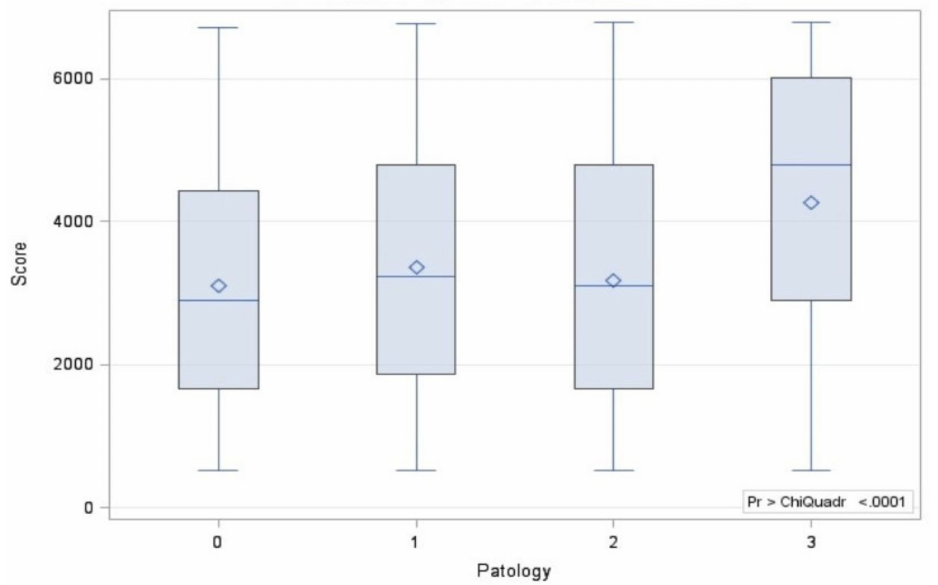
Figure 2. Correlation between SUVmax and the most common histological types of lung